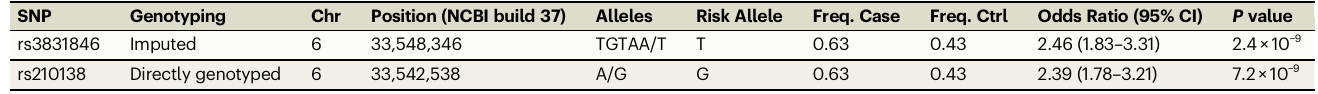
Table 1 | Association results for the imputed and directly genotyped lead variants